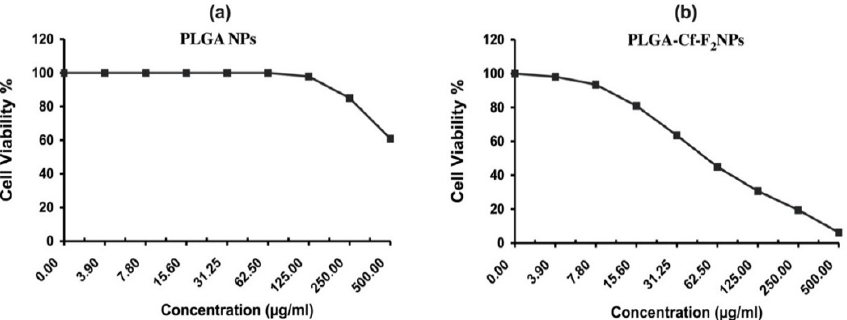
Figure 9. The percent cell viability of normal fibroblast cell lines (WI-38) upon treatment with serial concentrations of PLGA NPs ( a ), and PLGA-Cf-F 2 NPs ( b ).